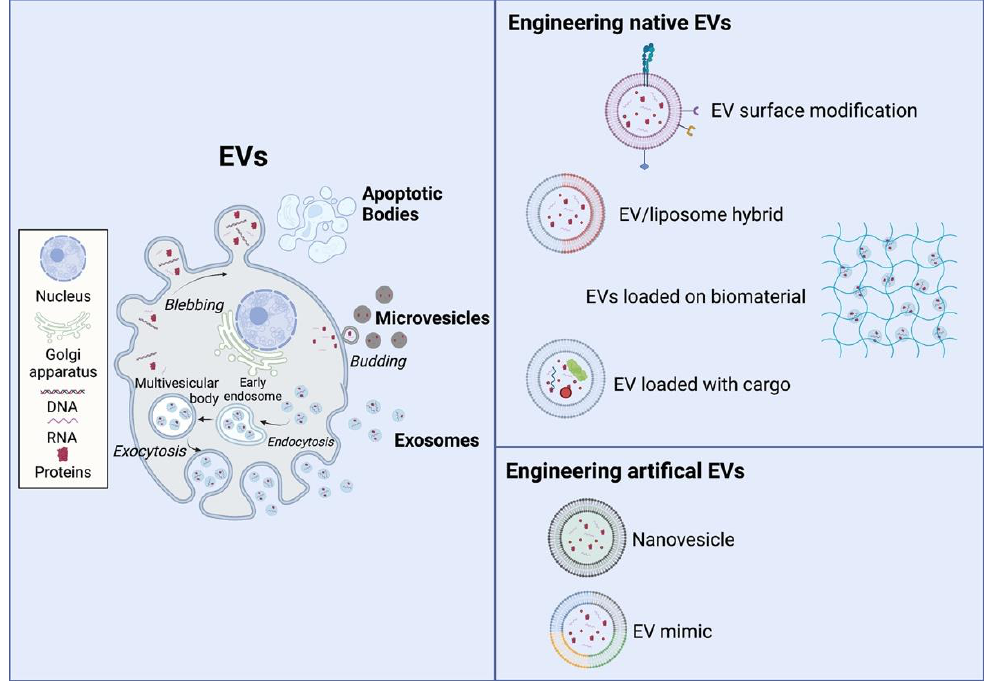
Figure 3. Engineering native EVs and artificial EVs.